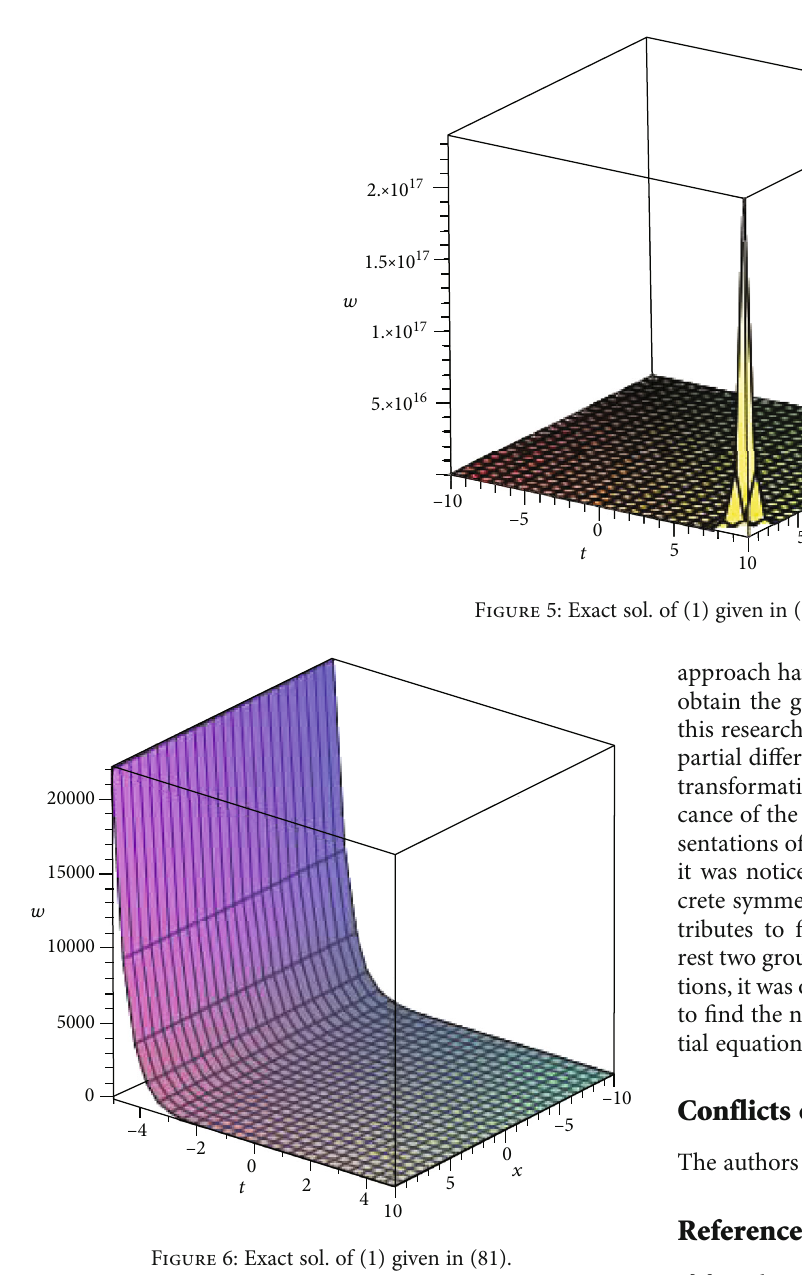
Figure 6: Exact sol. of (1) given in